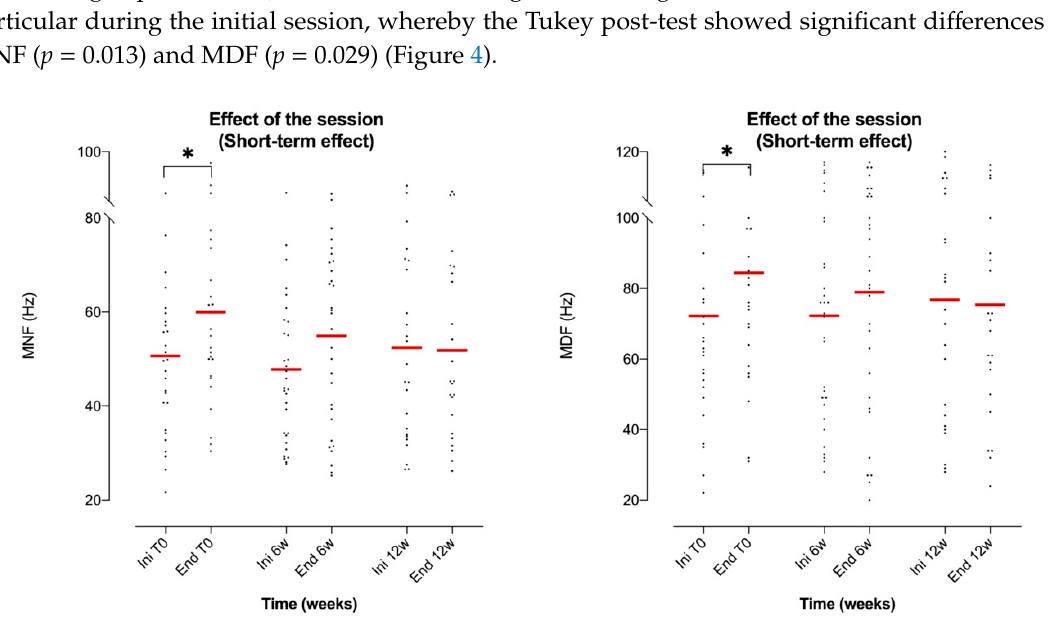
Figure 4. On the left, scatter dot plot of the mean values of RA MNF at the beginning and end of each session (Ini / End) regardless of the treatment time; on the right, scatter dot plot around the mean value of the RA MDF at the beginning and the end of each session (Ini / End) regardless of the treatment time. (T0: first session; 6w: week 6; 12w: week 12). Tukey multiple-comparison test: * ( p < 0.05).